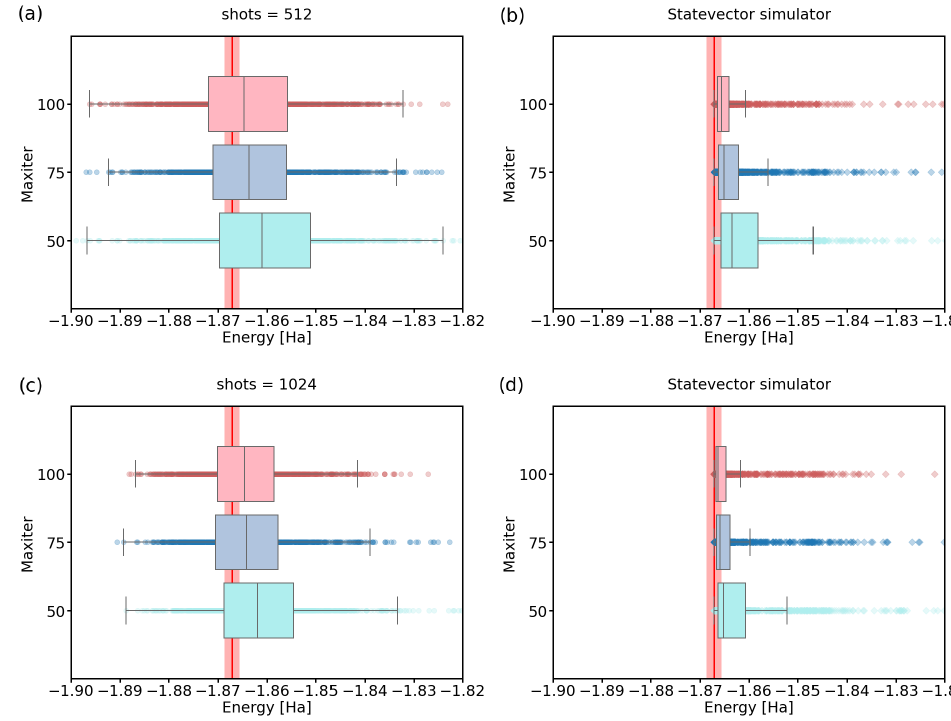
Figure 4. A recalculation of energies using statevector simulator for experiments with maxiter ∈ { 50,75,100 } , and ( a , b ) shots = 512; ( c , d ) shots = 1024. The red line represents the physical ground- state energy ( − 1.86712 Hartree) and the light-red background represents the chemical accuracy ( ± 0.0015